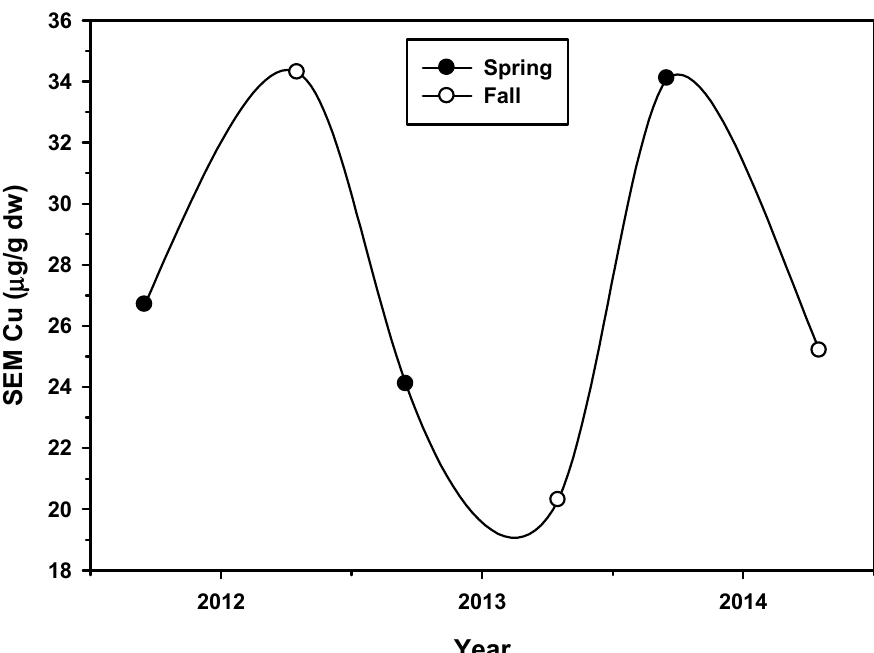
Figure 6. SEM copper concentrations (µg/g dry wt) from spring and fall sediment sampling at Cache Slough site CS-05 for the years 2012, 2013 and 2014.